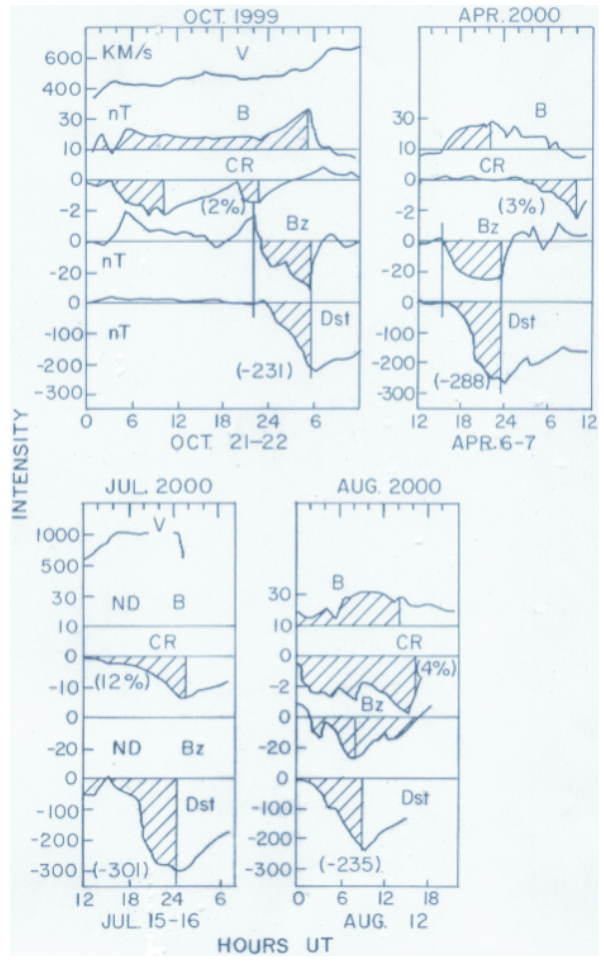
Fig. 2. Same as Fig. 1, for the four events 21–22 October 1999, 6–7 April 2000, 15–16 July 2000 and 12 August